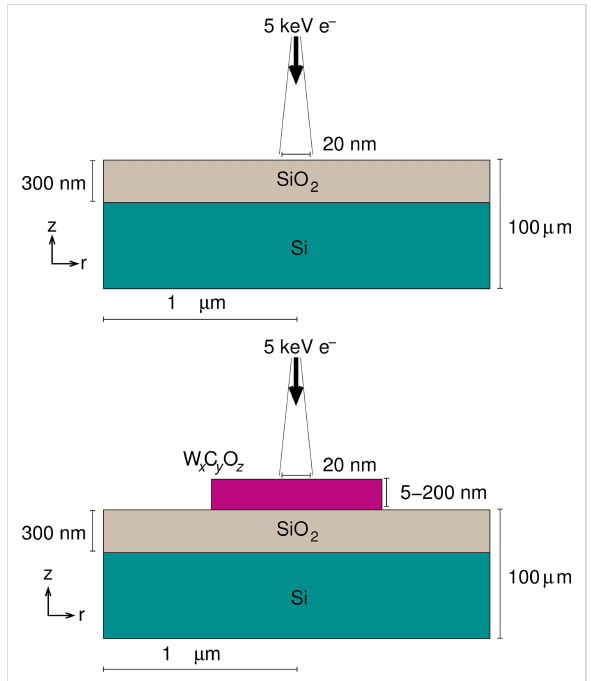
Figure 2: Cylindrical sample geometries used in the simulations. Top: A 300 nm thick amorphous SiO 2 substrate is placed on top of a Si wafer and is irradiated with 5 keV electrons. Bottom: W x C y O z deposits of thicknesses between 5 and 200 nm and of densities and composi- tions as given in Table 1 is placed on top a 300 nm amorphous SiO 2 layer, which in turn is placed on top of a Si wafer. A conical electron beam with a spot size of 20 nm on the sample is used, the point source being located 1 cm in vacuum above the center of the sample. The corresponding beam aperture is 5.73 × 10 − 5 degrees. A radius of 100 nm is chosen for the deposit.